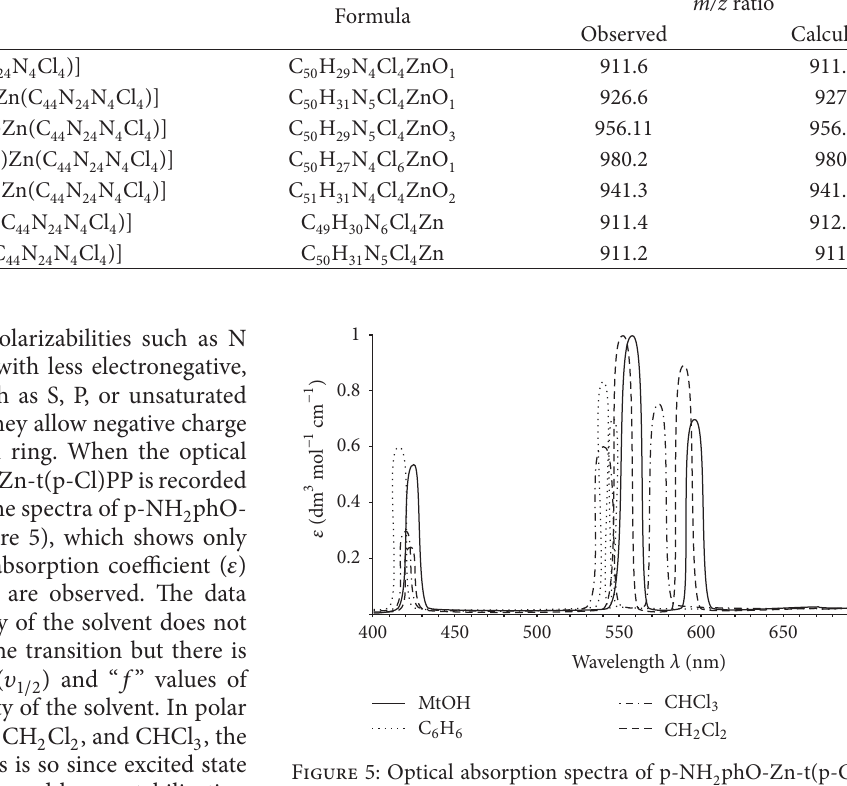
phO-Zn-t(p-Cl)PP 2